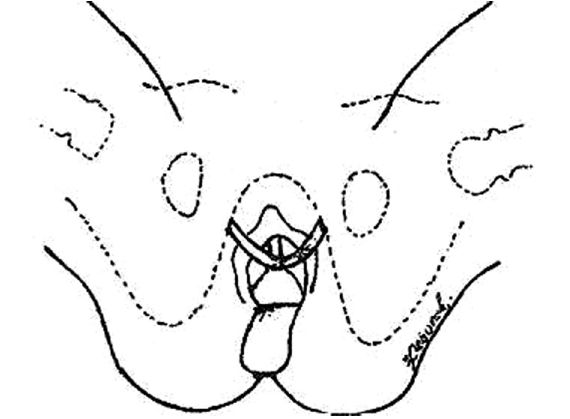
Figure 4 – Suburethral mini-sling anchored to the obturator internus muscles at the level of tendinous arc